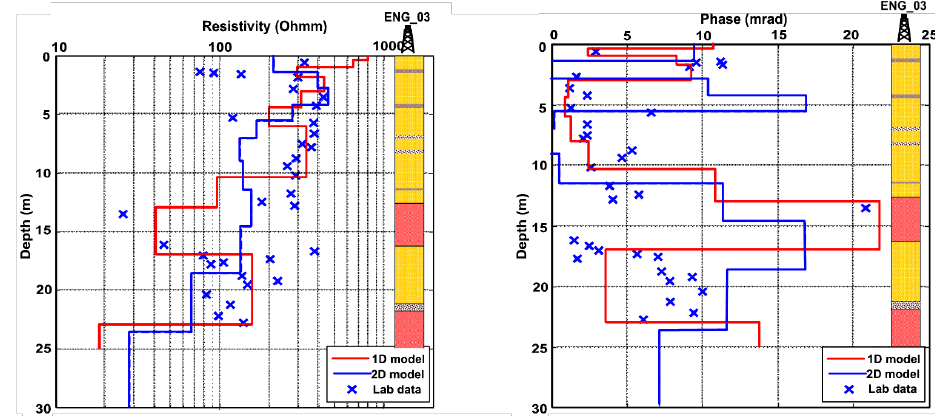
Fig. 8. Comparison of sounding, profiling and lab data at well ENG_03. Resistivity (left) and phase (right). 167